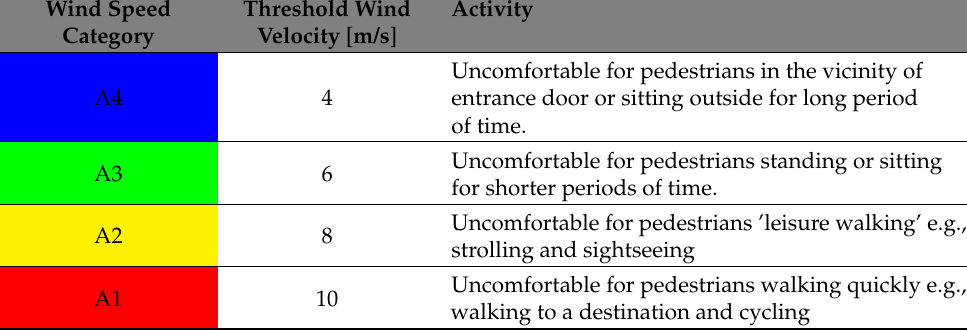
Table 3. Lawson comfort scale.